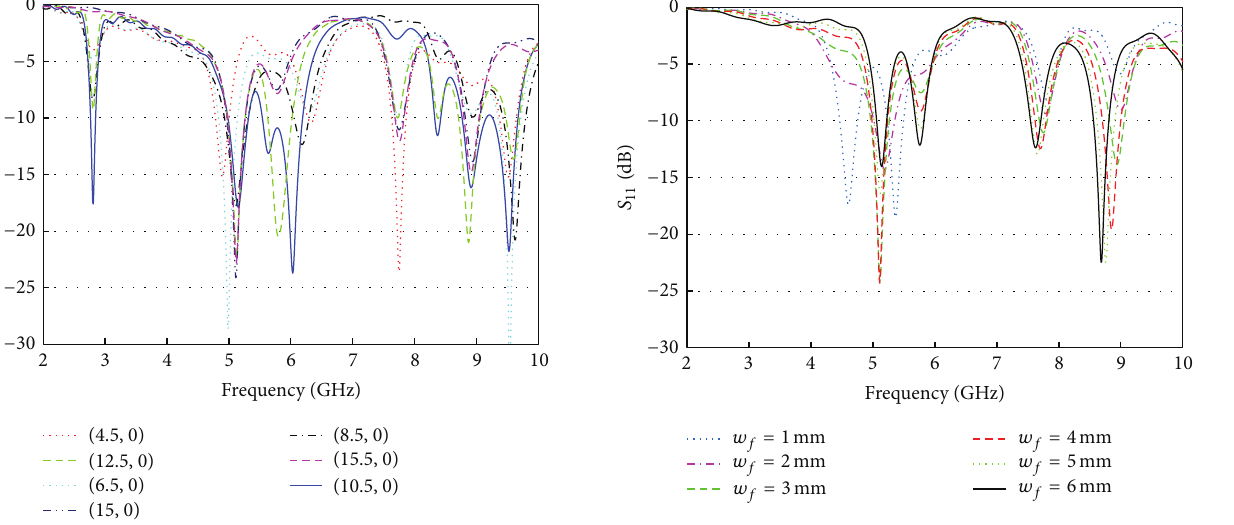
Figure 2: Selection of the feeding position (𝑥,𝑦) .